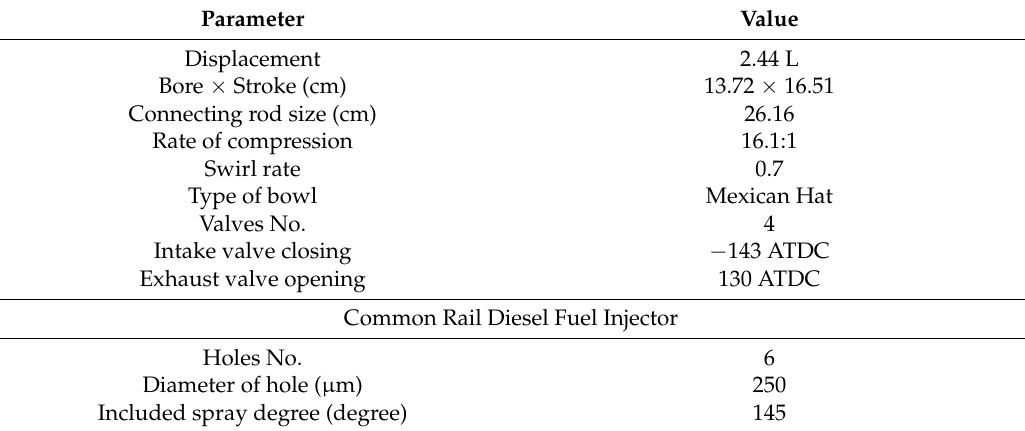
Table 1. Geometry of Cat ® 3401E SCOTE engine [17].